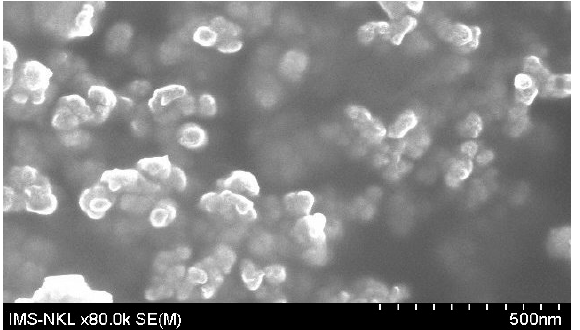
Figure 8. Field emission scanning electron microscopy (FeSEM) image of curcumin-loaded micelles. Free curcumin was purchased from Sigma-Aldrich (St. Louis, MO, USA). All other reagents and buffer solution components were of prepared analytical